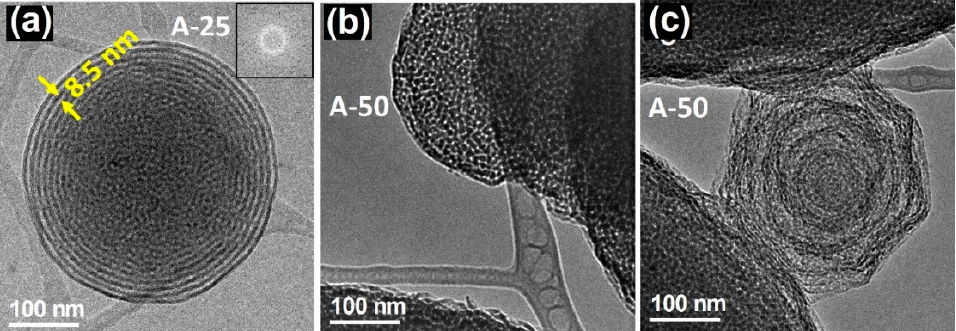
Figure 2. TEM images of A-A samples with different surfactant/silica ratio corresponding to ( a ) R25 and ( b , c ) R50. Adapted with permission from [32]. Copyright 2008 Trans Tech Publications Ltd. (Stafa-Zurich, Switzerland).